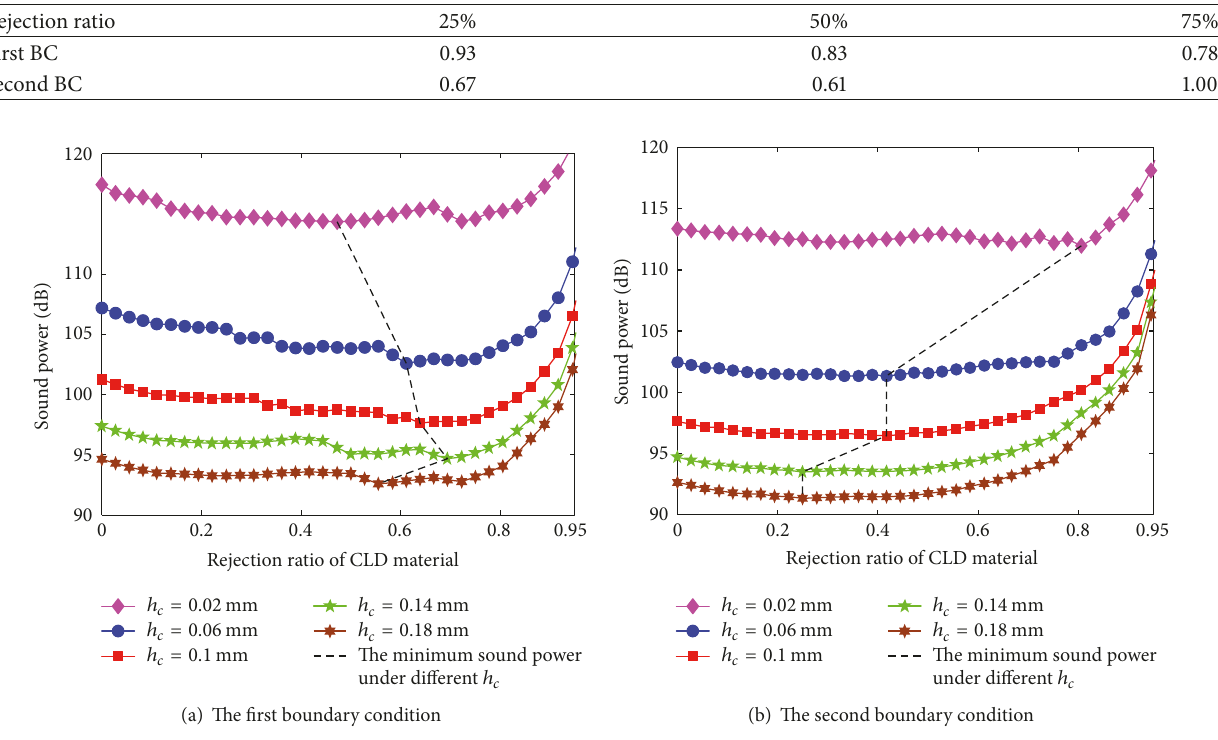
Figure 15: Influence for sound power with rejection ratios under various ℎ 𝑐